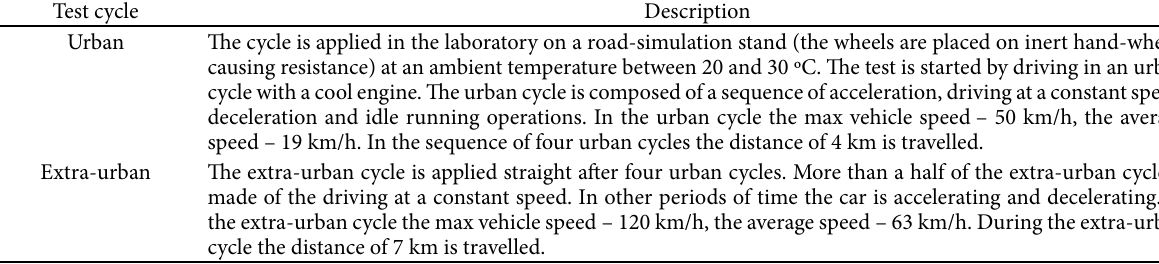
Table 1. Urban and extra-urban driving cycles Test cycle Description Urban